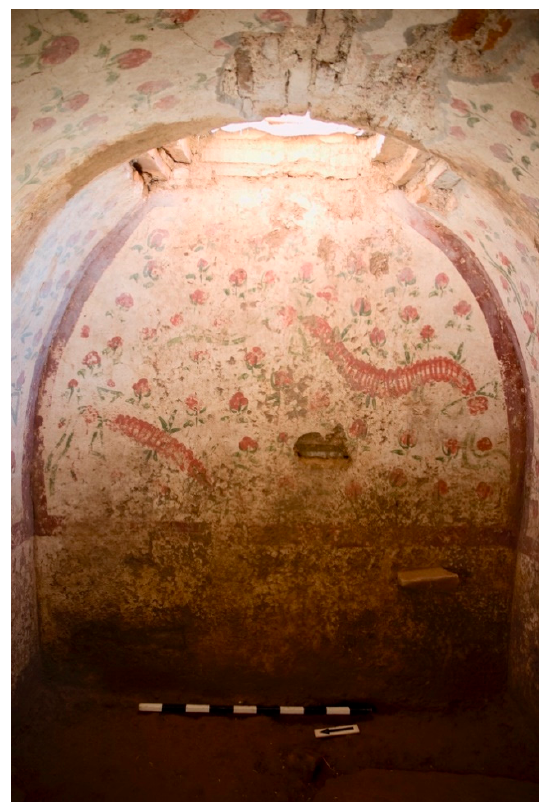
Figure A8. Sardis, Tomb 07.2 (Appendix A.5), east wall with cantilevered steps and entrance above. © Archaeological Exploration of Sardis/President and fellows of Harvard College.